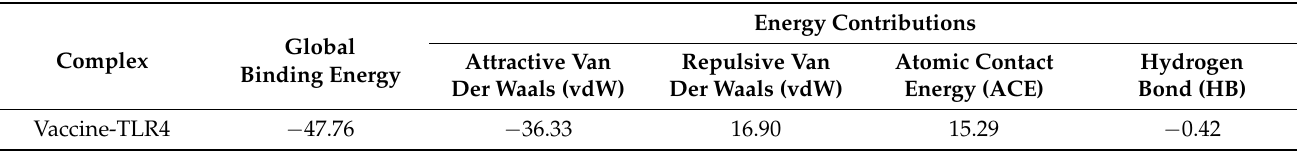
Figure 4. Predicted 3D structure of the vaccine and its quality assessment. ( A ) Predicted 3D structure of the vaccine (black) showing T cell epitopes in red, while B cell epitopes in orange, ( B ) Ramachandran plot for the 3D structure of the vaccine showing 97.8% of the residues in the favorable region, ( C ) ProSA z-score for the 3D structure of the vaccine, determined using NMR spectroscopy (dark blue) and X-ray crystallography (light blue). Table 6. Docking results of the developed vaccine with human toll-like receptor 4 (TLR4). The table shows global binding energy as well as different forces contributing to the global